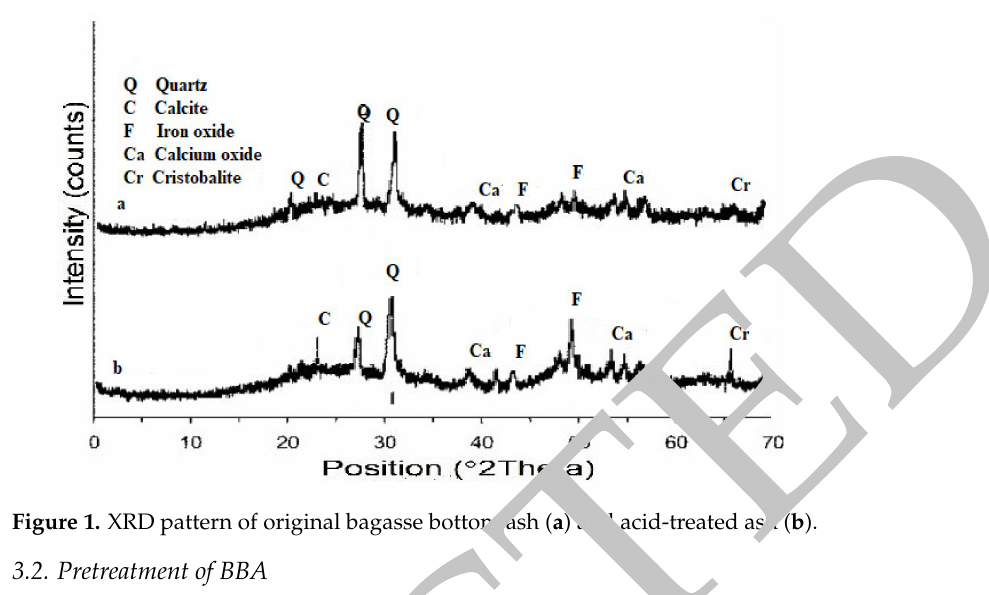
Figure 1. XRD pattern of original bagasse bottom ash ( a ) and acid-treated ash ( b